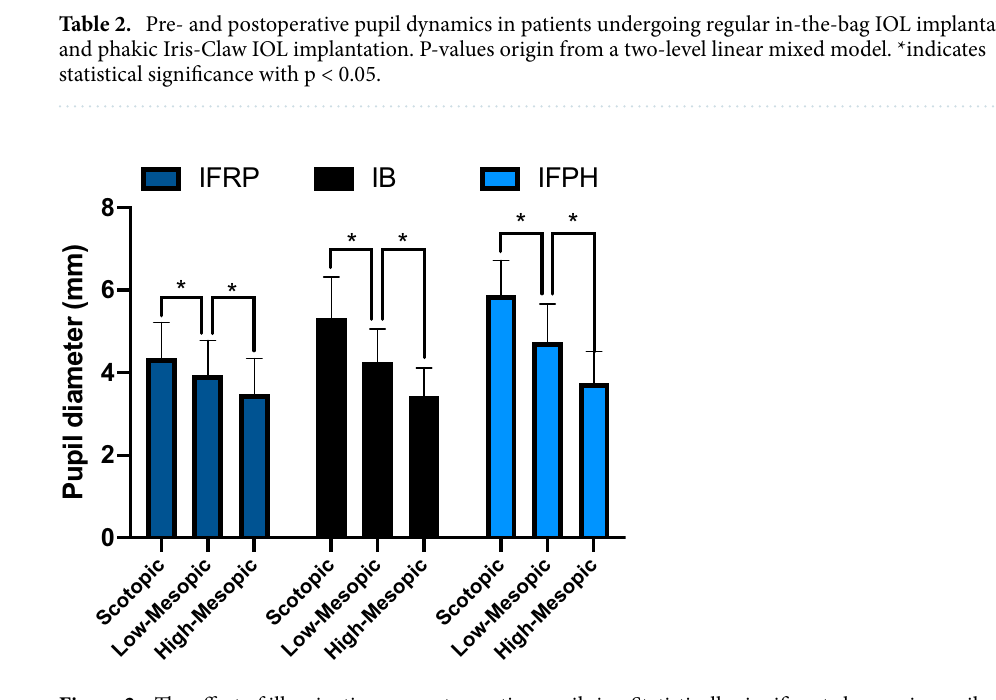
Figure 2. The effect of illumination on postoperative pupil size. Statistically significant changes in pupil diameter were observed between the 3 levels of illumination within each surgical group.